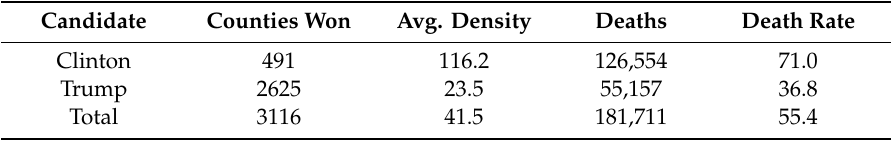
Table 2. Population density and COVID-19 deaths by 2016 electoral outcome (31 August 2020).